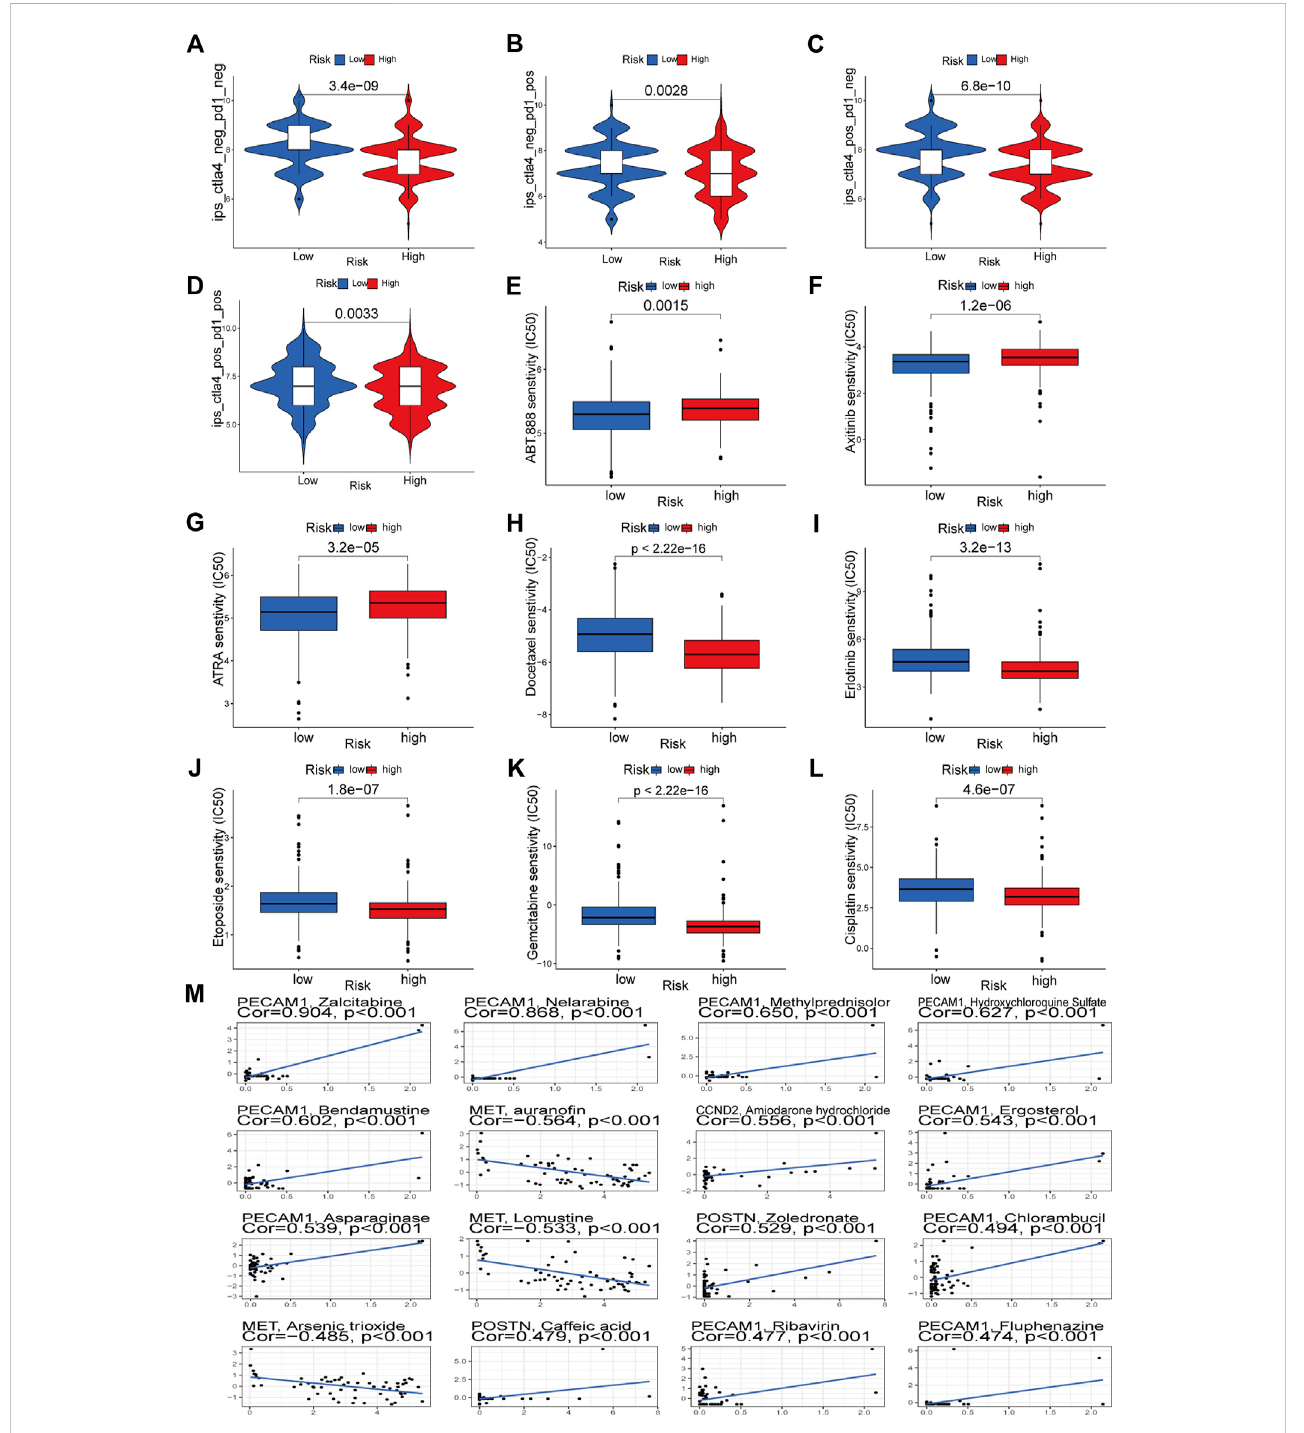
FIGURE 12 Immunotherapeutic responses of the ARGs prognostic signature and drug sensitivity analysis. (A – D) Comparison of the immunophenoscore (IPS) between the low- and high-risk groups strati fi ed by both CTLA4 and PD-1. (E – L) Drug sensitivity analysis. (M) Multiple drugs for six signature genes.